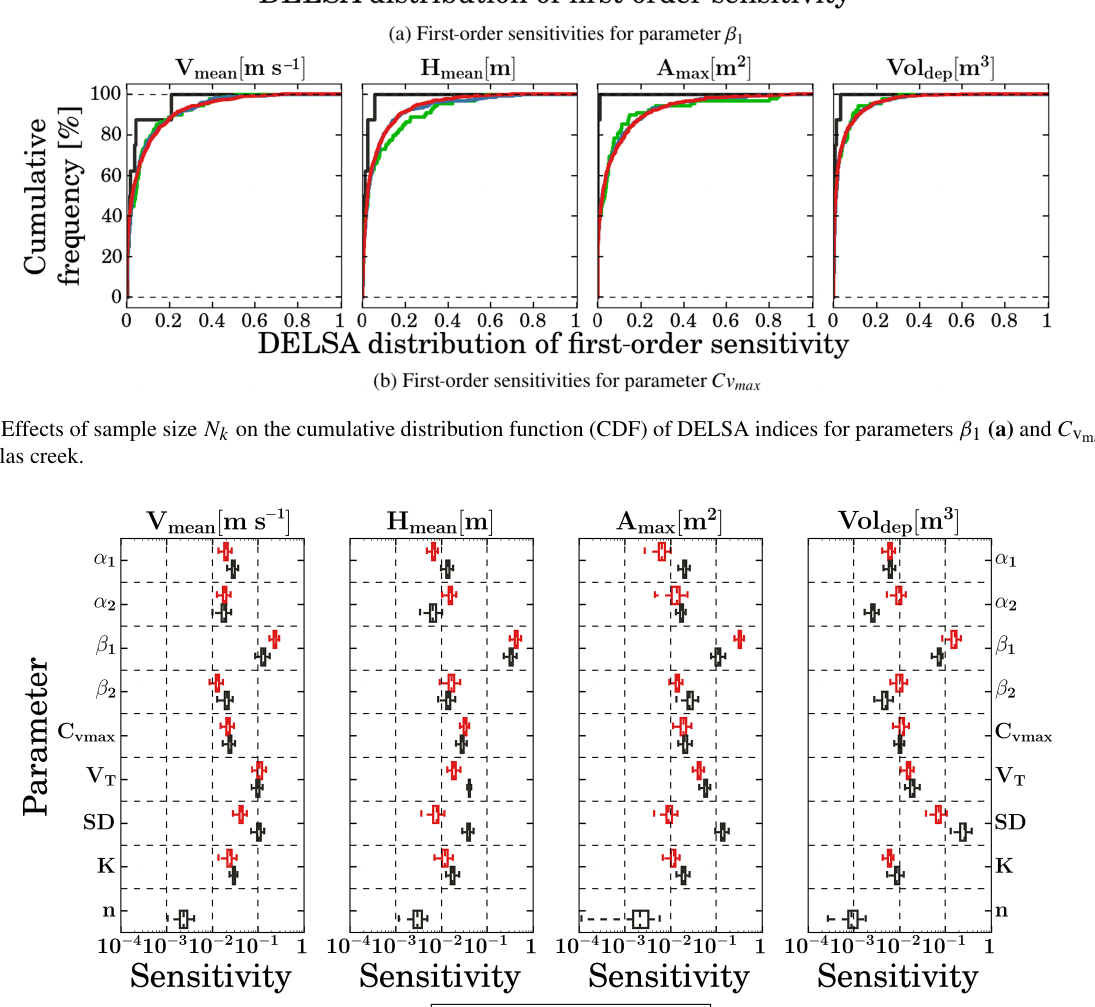
Figure 4. DELSA sensitivity indices (synthetized as the median from the cumulative frequency distribution) for all parameters and model re- sponses. Results are displayed for Acerillas (red) and La Mesilla (black) creeks, and the sampling uncertainty (bootstrapping with 1000 times resampling) is indicated by boxplots. The vertical bold line in the boxplot is the median; the body of each boxplot shows the interquartile range ( Q 75 – Q 25 ); and the whiskers represent the sample minima and sample maxima. DELSA indices are displayed in log space for a better visualization of inter-parameter